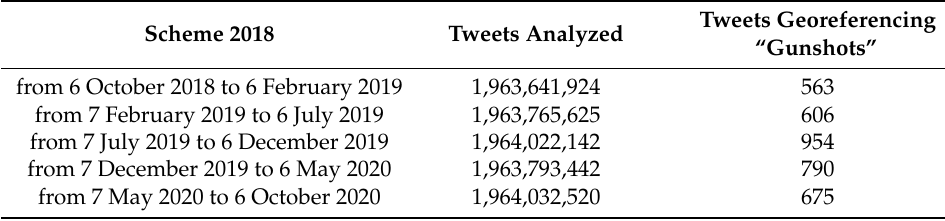
Table 1. Subset of georeferenced tweets on